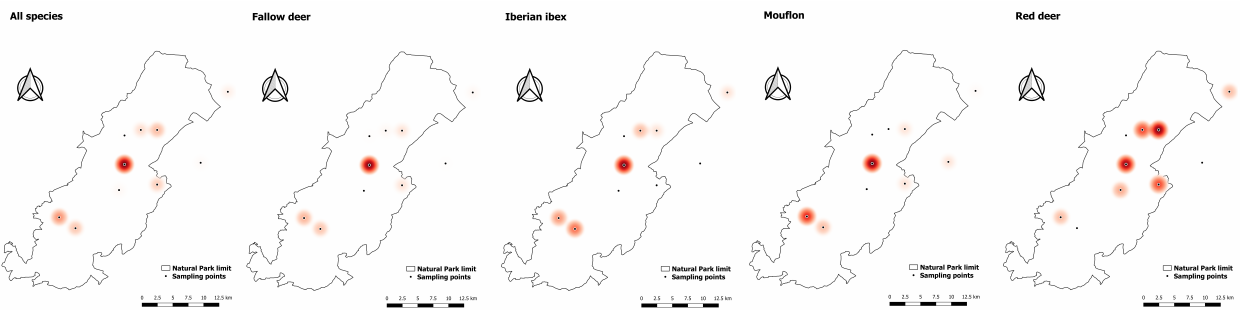
Figure 4. Spatial distribution of parasite abundance, considering all the host species together or each single wild ruminant species. A higher abundance corresponds to more intense